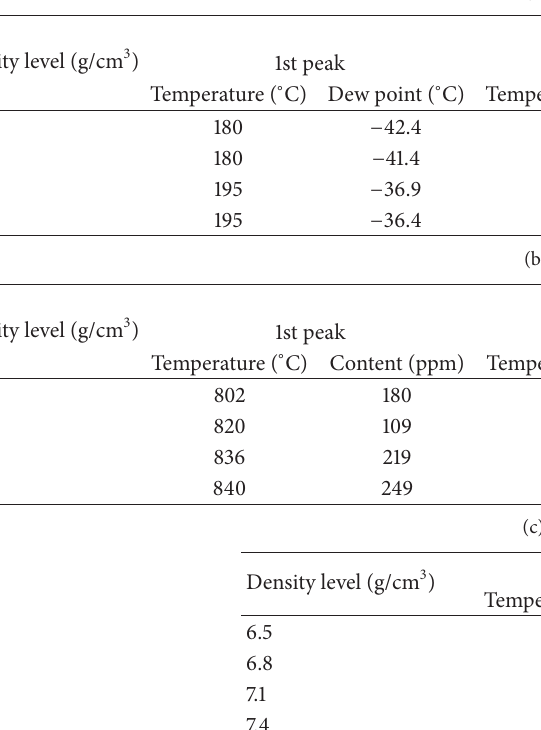
O profile and corresponding amounts of active constituent 2 profile and corresponding amounts 2